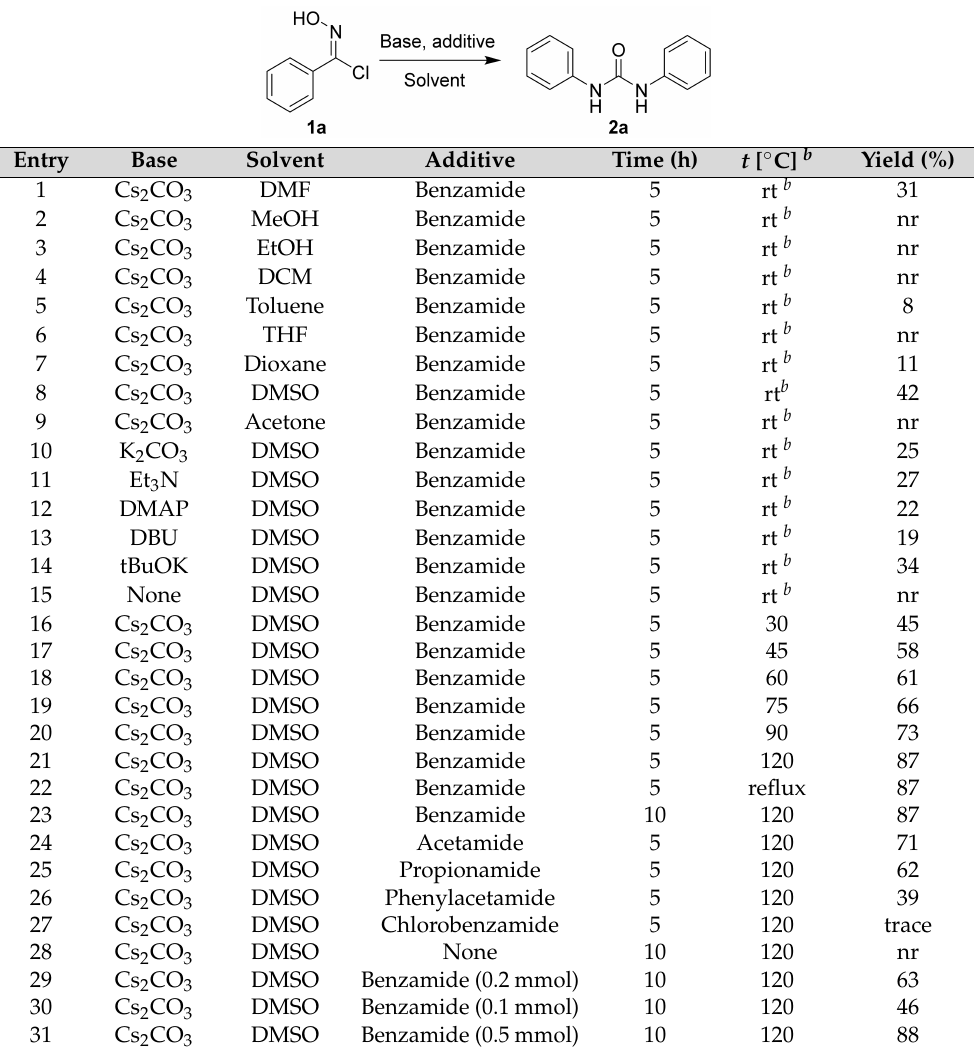
Table 1. Optimization of experimental conditions a,c